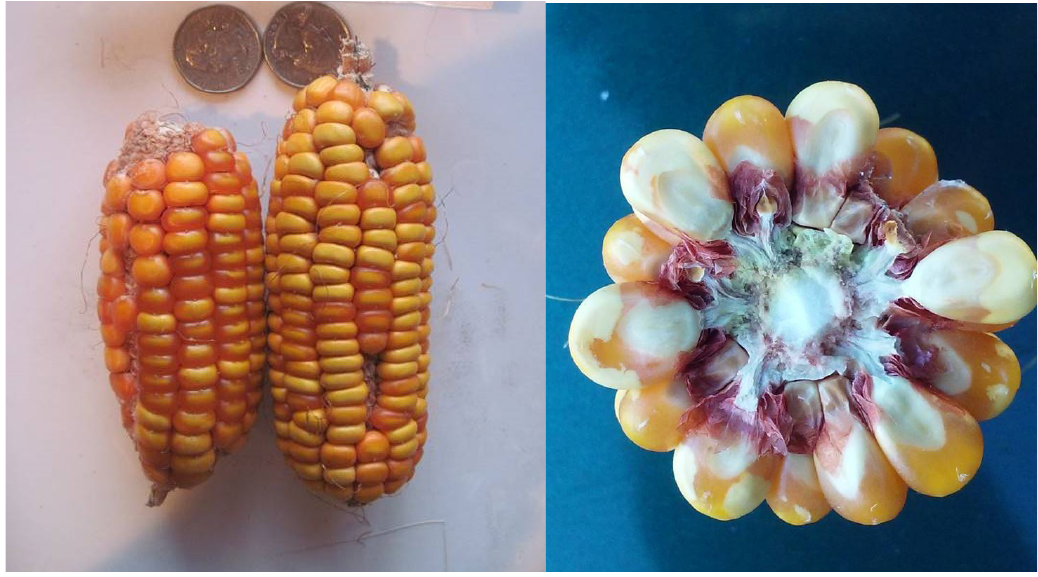
Figure 2: Picture on the left shows ears of breeding line AR21B-1-7-7-7-2-3-2 still unstable for the opaque trait after 6 generations of self- pollination. The picture on the right shows piebald opaque kernels from an inbred line derived from selfing the commercial inbred LH123Ht